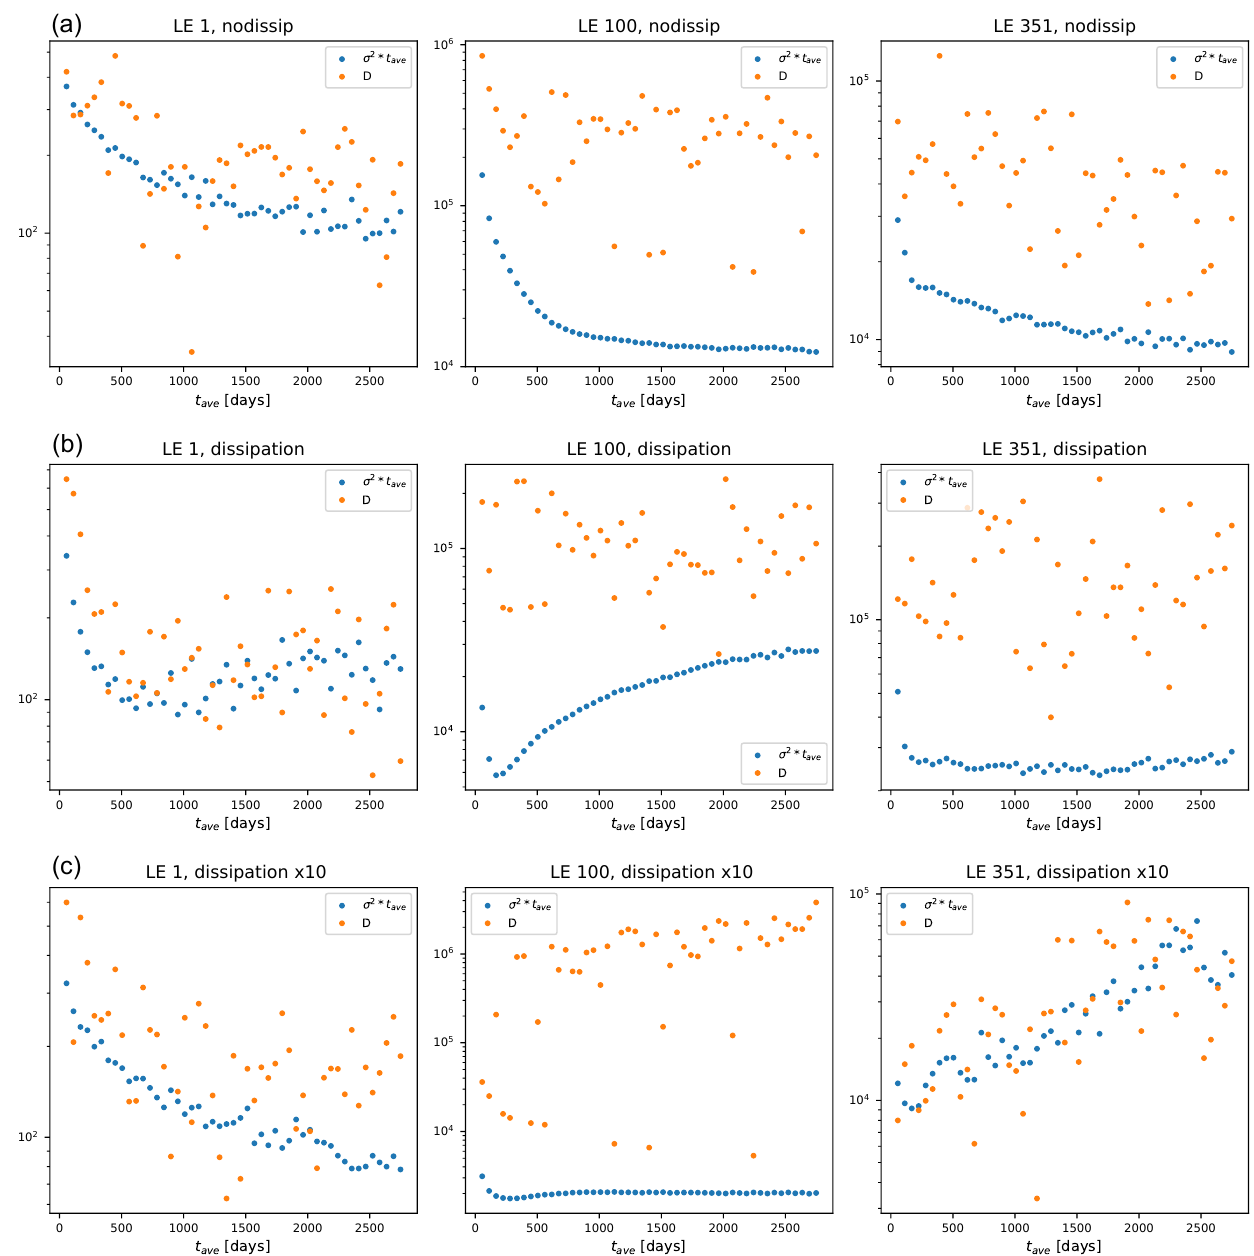
Figure A4. The metric σ 2 · t ave versus the diffusion coefficient D , derived from the inverse of the second derivative at the minimum of the rate function, as a function of the block averaging length t ave for different Lyapunov exponents of the “9 × 9” configuration of MAOOAM. Note the logarithmic scale of the y -axis, in contrast to Fig. A2. The Lyapunov index is shown in the title. Panels (a) show the results for the experiment without scale-dependent dissipation, panels (b) correspond to the reference value for dissipation, and panels (c) show the results for an enhanced dissipation